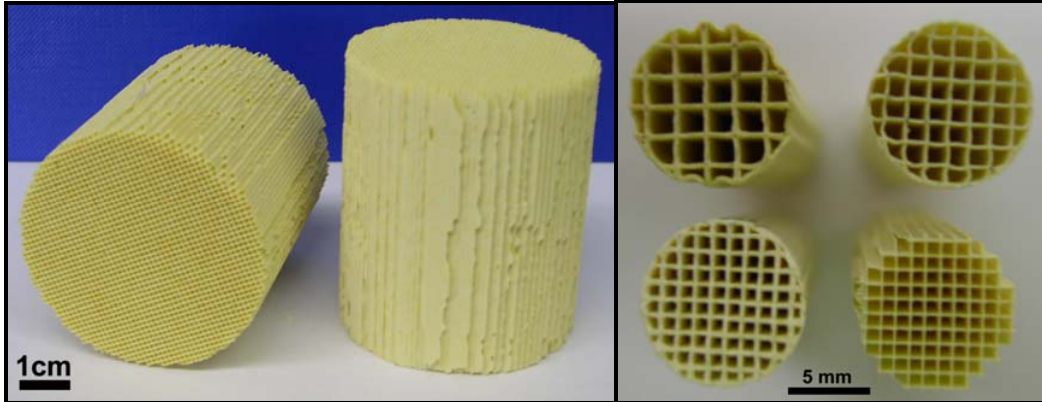
Figure 1. Ceramic honeycomb monoliths with different cell